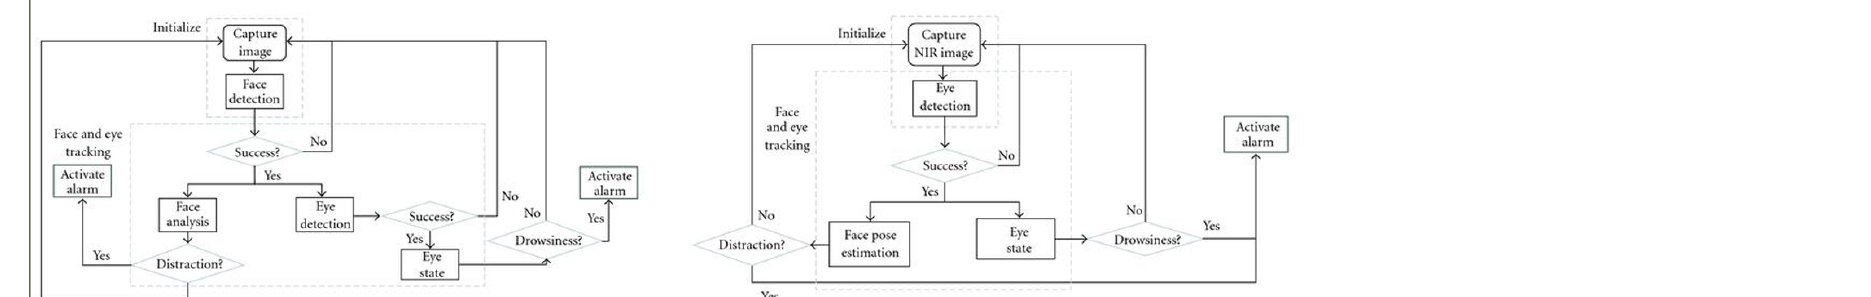
Figure 1 Algorithm scheme: (a) day system, (b) night